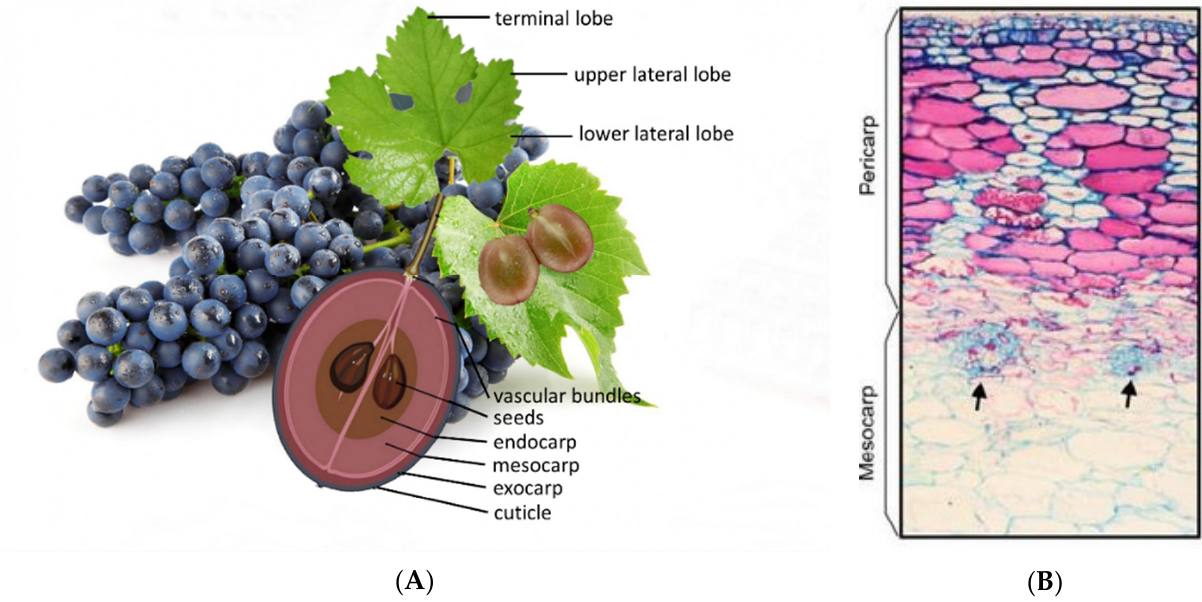
Figure 2. ( A ) Vine cluster with leaves and a schematic structure of a grape berry. ( B ) Anatomical section of pericarp and mesocarp of the grape berry. Arrows indicate the peripheral carpellary bundles. Adapted from Zhang et al. 12 .